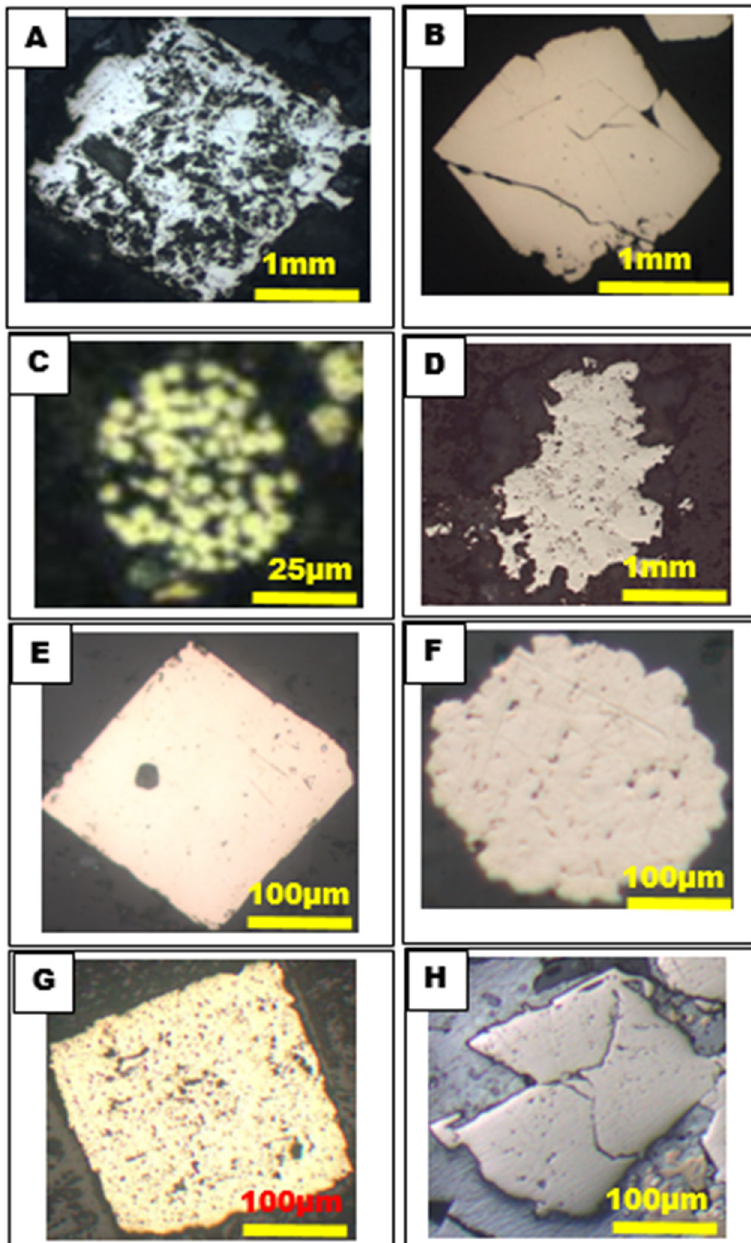
Figure 7. Photomicrographs of pyrite crystals from selected formations. ( A ) Euhedral pyrite from the Machinchang Formation (LA ‐ 3312B). ( B ) Singa Formation pyrite (LA ‐ 5312B). ( C ) Sedimentary pyrite from the Semantan Formation (ME ‐ 5912). ( D ) Subhedral pyrite from the BRSZ Unit 1 (BE ‐ 2412B). ( E ) Pyrite from Ilmenite ‐ series, igneous rock (BG ‐ 0313). ( F ) Selinsing pyrite (SEL ‐ R009 ‐ 7). ( G ) Tersang pyrite. ( H ) Penjom pyrite (PEN ‐ R16A).